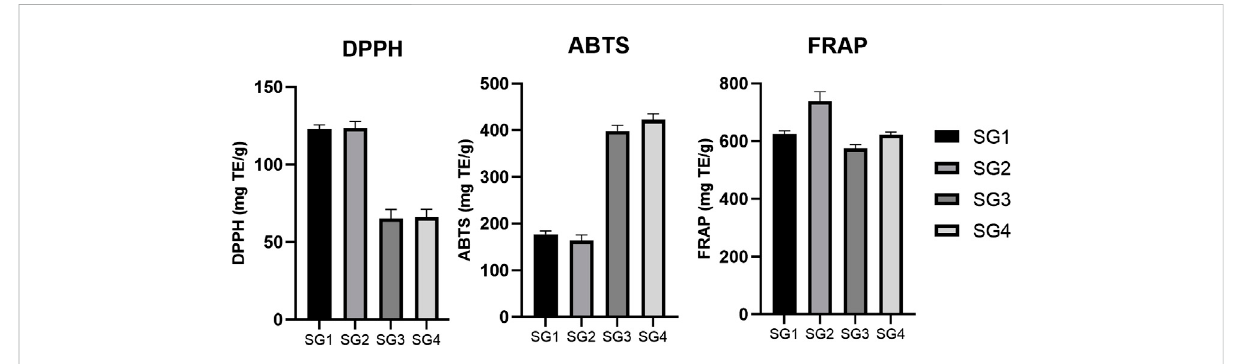
FIGURE 3 ComparisonbetweentheDPPH,ABTS,andFRAP invitro antioxidantactivitydeterminedfortheSGsamples.Theresultsareexpressedasrelative means ± standard deviation of three parallel measurements.